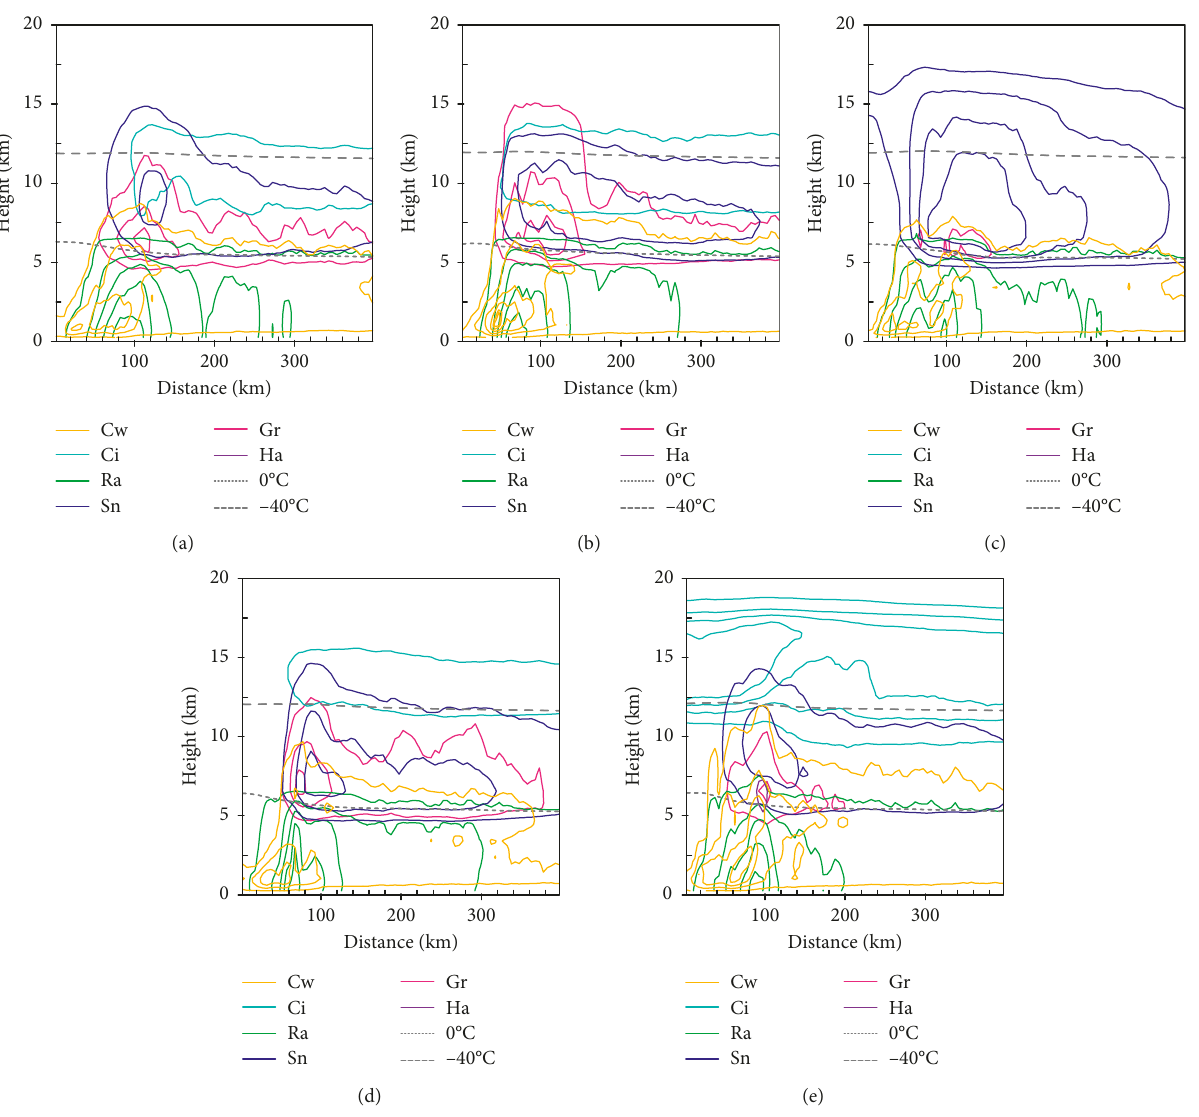
Figure 6: Vertical cross sections of time-domain ensemble mean of cloud water content (Cw; orange contour lines; every 0.1gm − 3 , starting at 0.02gm − 3 ), rain water content (Ra; green contour lines; every 0.2 gm − 3 , starting at 0.02g m − 3 ), cloud ice content (Ci; cyan contour lines; every 0.05gm − 3 , starting at 0.02gm − 3 ), snow water content (Sn; blue contour lines; every 0.1g m − 3 , starting at 0.2g m − 3 ), graupel water content (Gr; pink contour lines; every 0.1gm − 3 , starting at 0.2g m − 3 ), and hail water content (Ha; purple contour lines; every 0.005g m − 3 , starting at 0.01g m − 3 ); the gray dot-dash lines indicate 0 ° C contour lines; gray short-dash lines indicate − 40 ° C temperature contour lines; from 0000 to 2400 UTC 5 July 2014, within a radius of 400km from the cyclone center, for (a) WSM6, (b) GSFC, (c) THOM, (d) MORR, and (e)